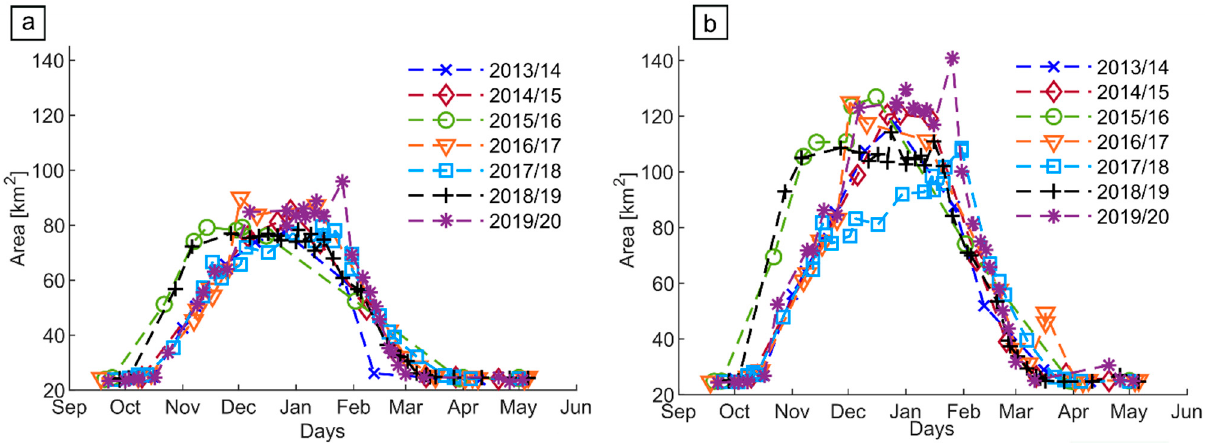
Figure 10. ( a ) Temporal trend of area in W class (open water); ( b ) temporal trend of area in W or M class (open water or mosaic of water, mud and vegetation).